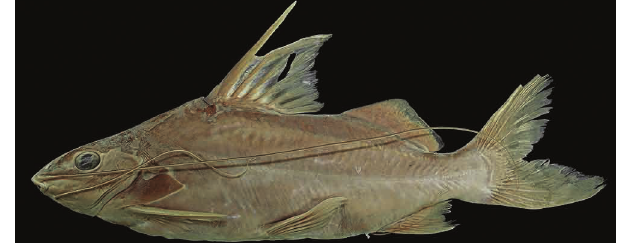
Fig. 3. Pimelodus argenteus , MCP 19248, 204.7 mm SL, Bella Vista, río Paraná, Corrientes, Argentina. Photo by André Canto.